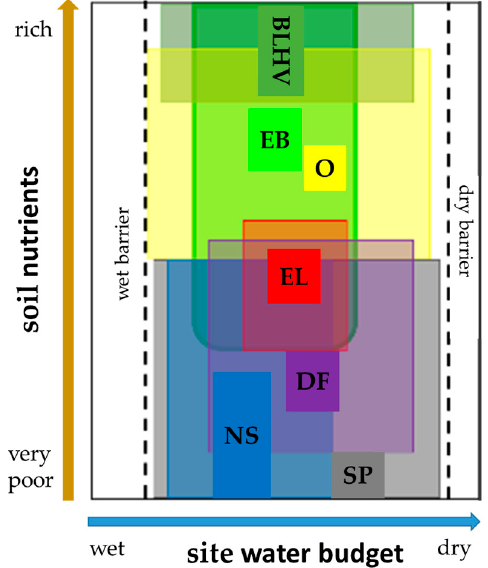
Figure 4. Simplified ecogram to assign species based on a matrix of soil nutrients and site water budget in the North German Plain (BLHV: broadleaves of high value; EB: European beech; O: oak species; EL: European larch; DF: Douglas-fir; NS: Norway spruce; SP: Scots pine).